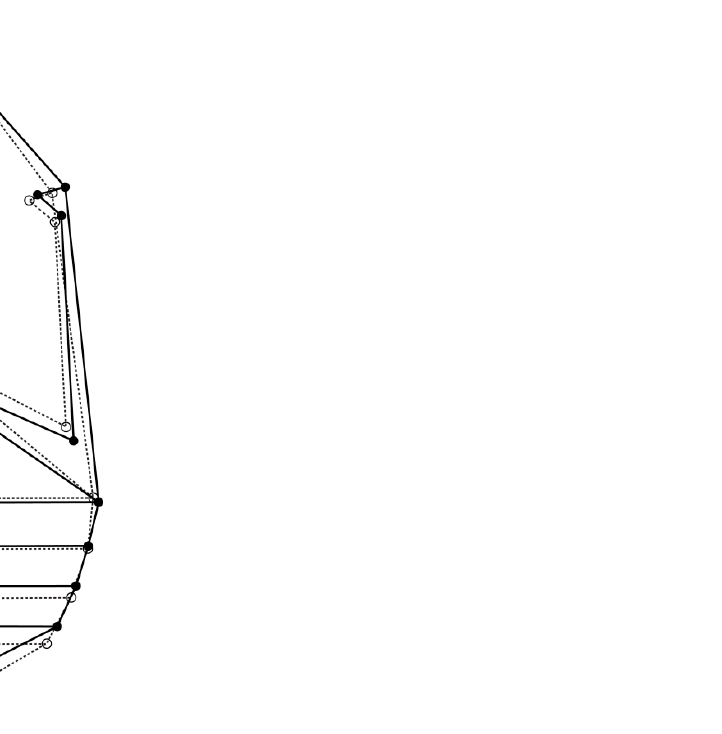
Figure 3. Discriminant functional analyses of seed beetles. The outline graphs show differences in shape between Acanthoscelides obtectus females (solid line) and males (dashed line).